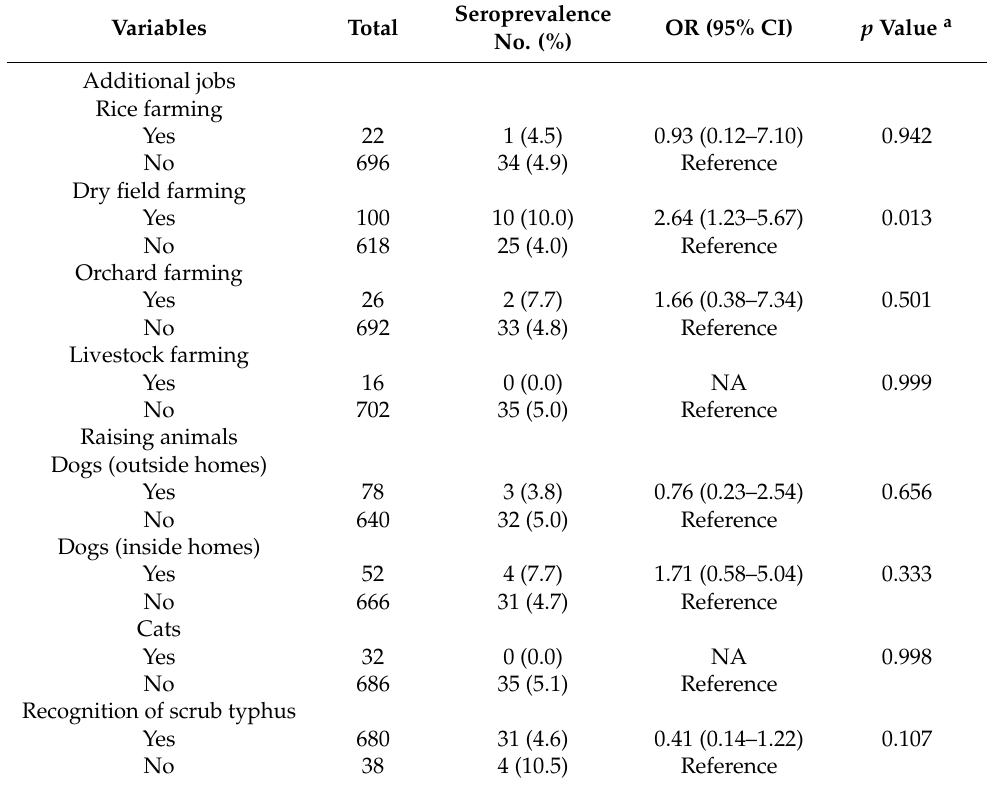
Table 5. Association between other potential factors and scrub typhus seroprevalence among National Park Office forestry workers in South Korea.